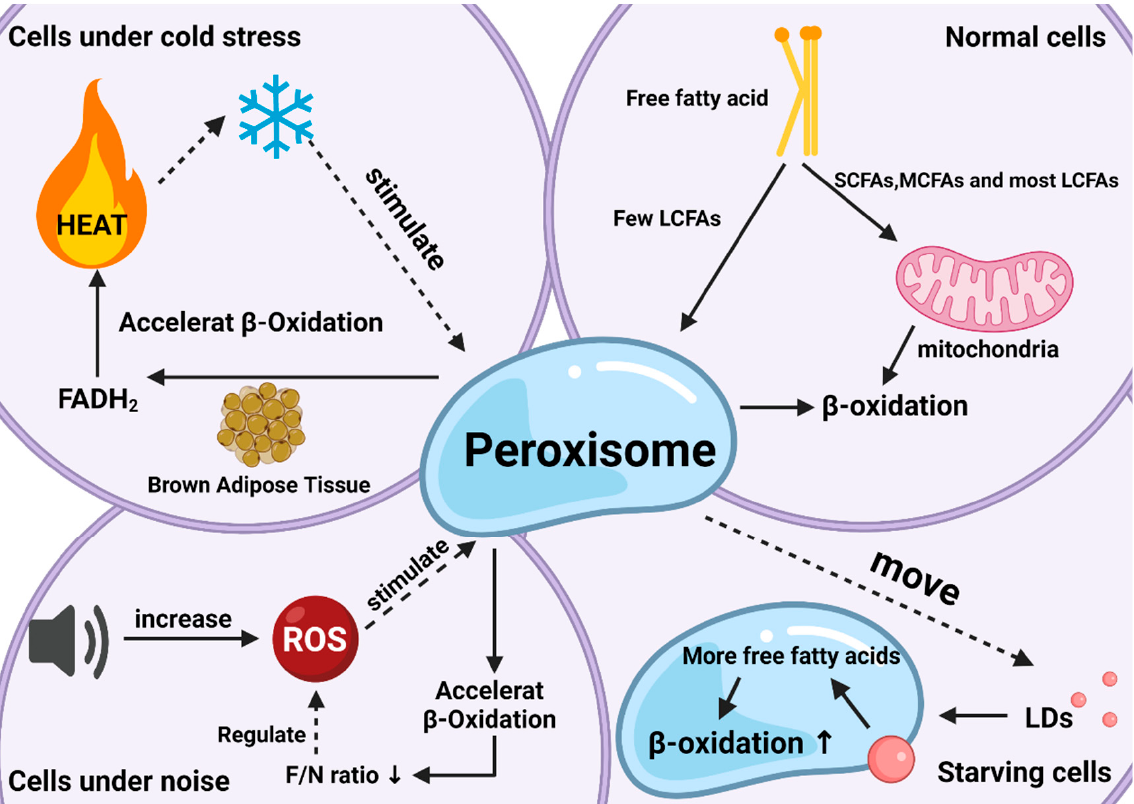
Figure 2. The roles of peroxisomal β -oxidation under various conditions. Responses and effects of peroxisomal β -oxidation in cells under normal ( top right ), starvation ( bottom right ), cold stress ( top left ), and noise ( bottom left ) conditions.